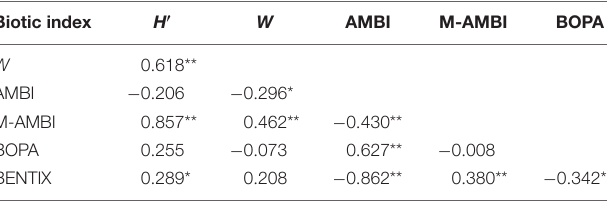
TABLE 3 | Results of correlation analysis among six biotic